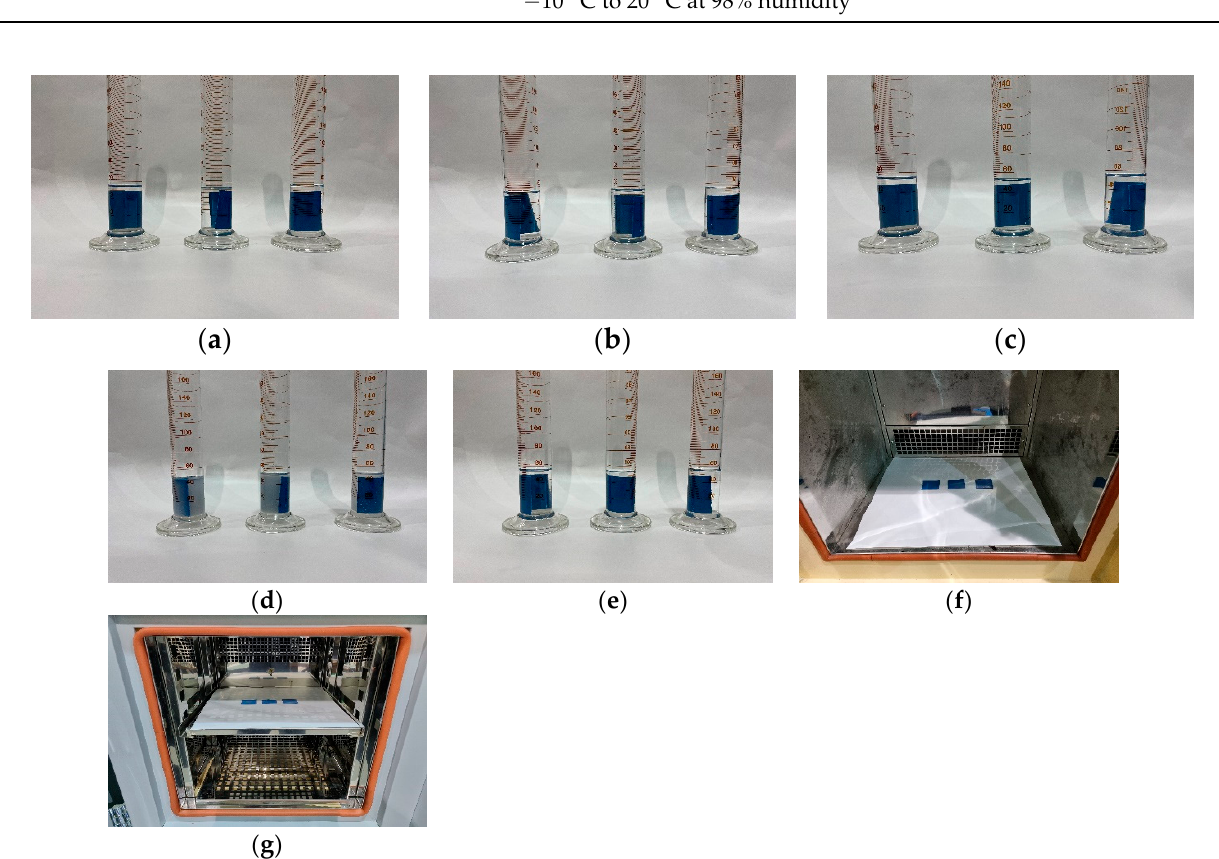
Figure 12. The deterioration status of specimens: ( a ) Hydrochloric acid treatment; ( b ) Nitric acid treatment; ( c ) Sulfuric acid treatment; ( d ) Alkali treatment; ( e ) Sodium chloride treatment; ( f ) Freeze- thaw treatment; ( g ) Repeated wet-dry treatment.